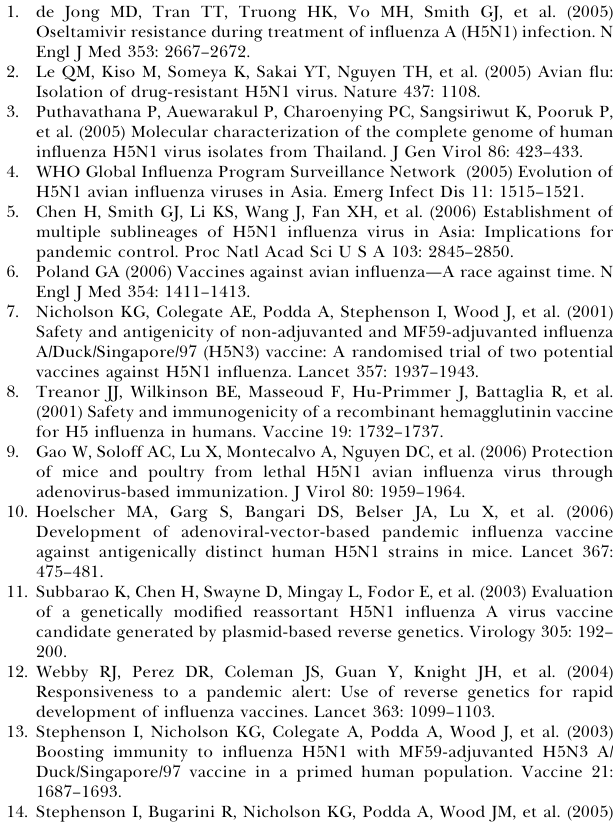
Table S1. Assessment of Pathogenicity and Infectivity of H5N1 ca Viruses in